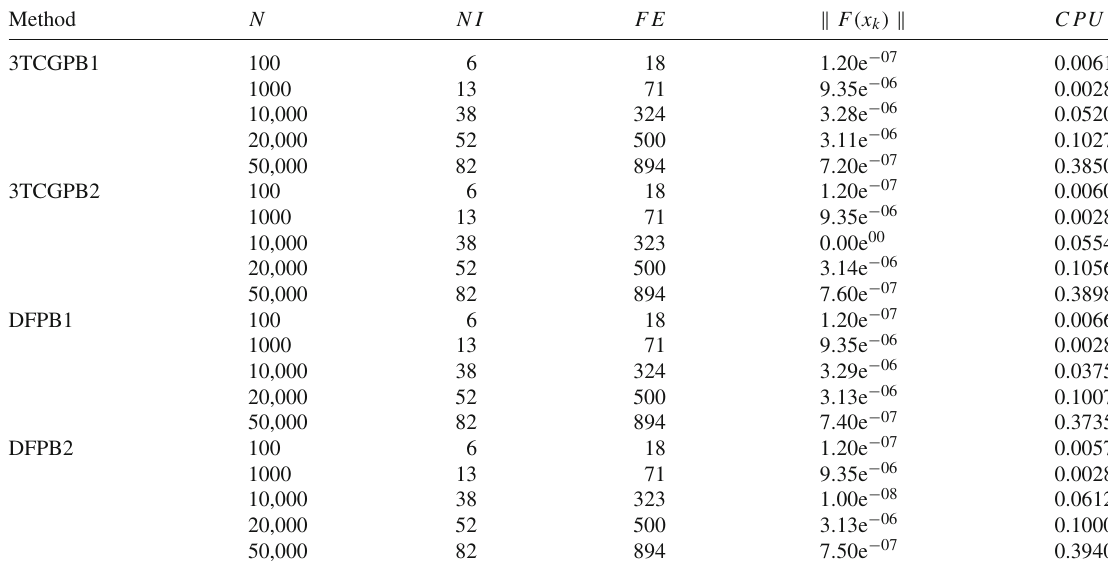
Table 1 Numerical results of Problem 4.1